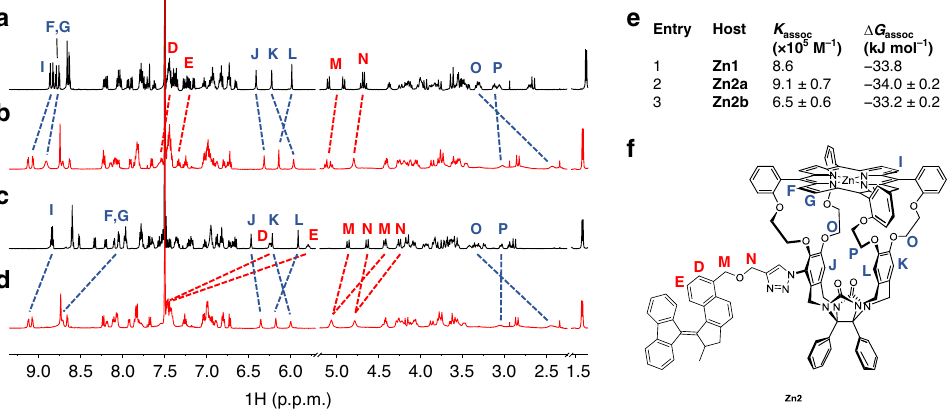
Fig. 4 Characterization of host – guest complexes. a – d 1 H NMR spectra of a Zn2a , b Zn2a·V12 , c Zn2b , and d Zn2b·V12 (500 MHz, c = 10 − 3 M in CDCl 3 / CD 3 CN, 1:1, v/v, 298K). The shift changes of relevant cage protons are indicated in red and those of relevant motor protons in blue. e Association constants and Gibbs binding free energies of complexes between porphyrin macrocycles and methyl viologen bis(hexa fl uorophosphate) ( V12 ) at 298 K in CHCl 3 /CH 3 CN, 1:1, v/v. f Molecular structure of Zn2 , with protons D – G and I –